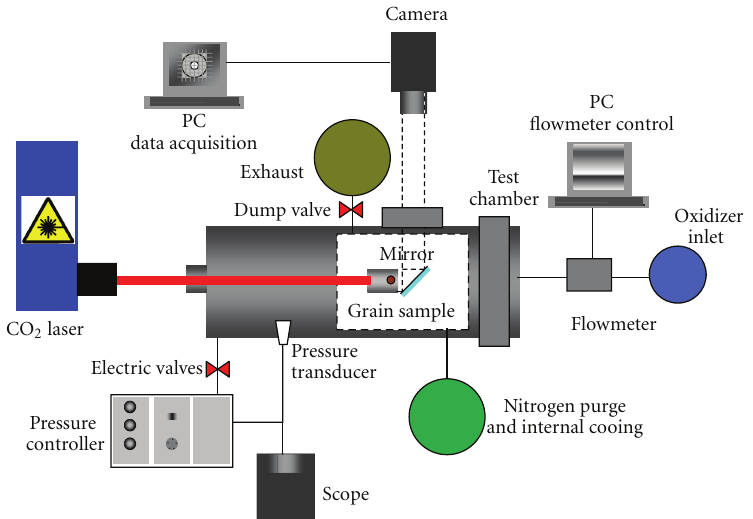
Figure 1: Experimental setup scheme highlighting the axial oxidizer inlet, the laser ignition apparatus, and the data acquisition hardware [16]. Note the 45 ◦ mirror enabling sample head-end visualization.